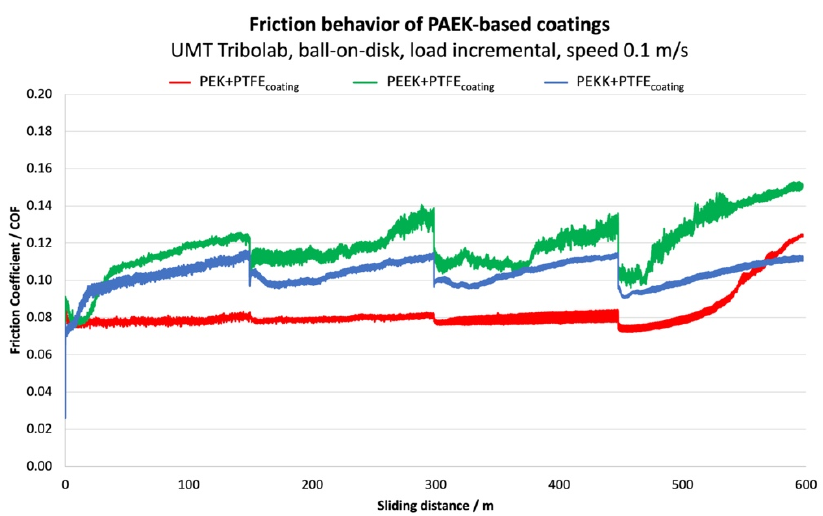
Figure 14. Friction coefficient of the coatings tested in incremental load conditions .